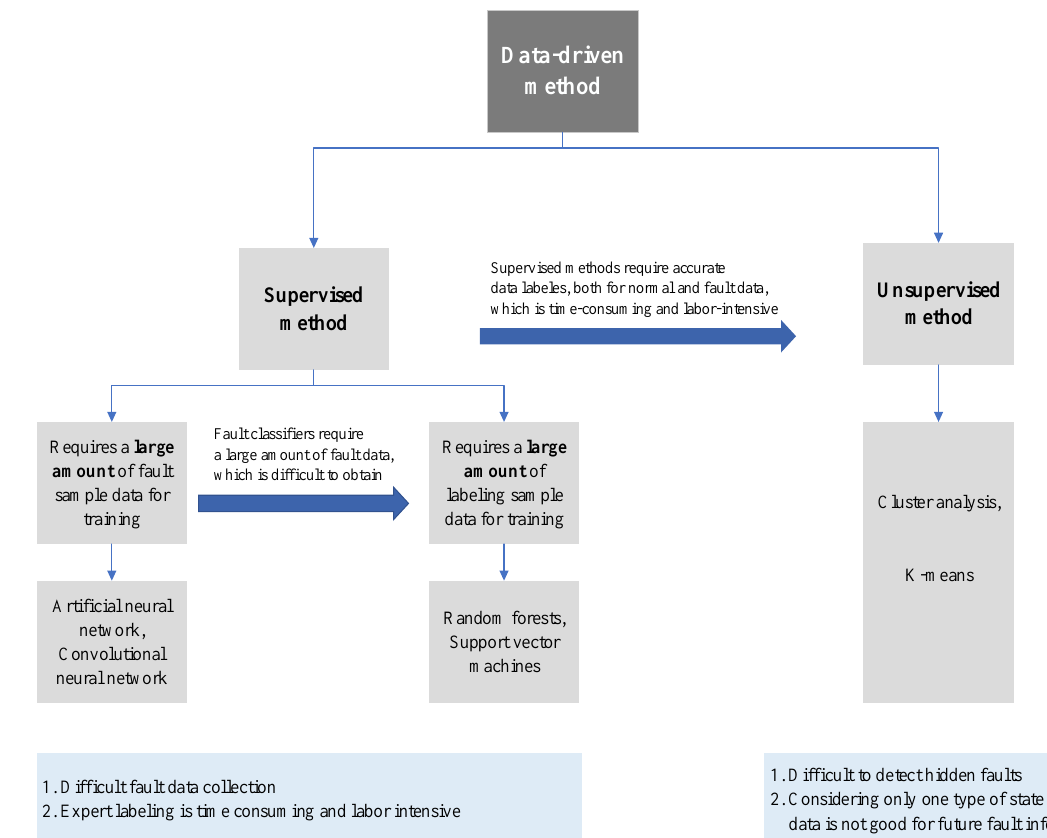
Figure 1. Logical relationship diagram of supervised and unsupervised methods.